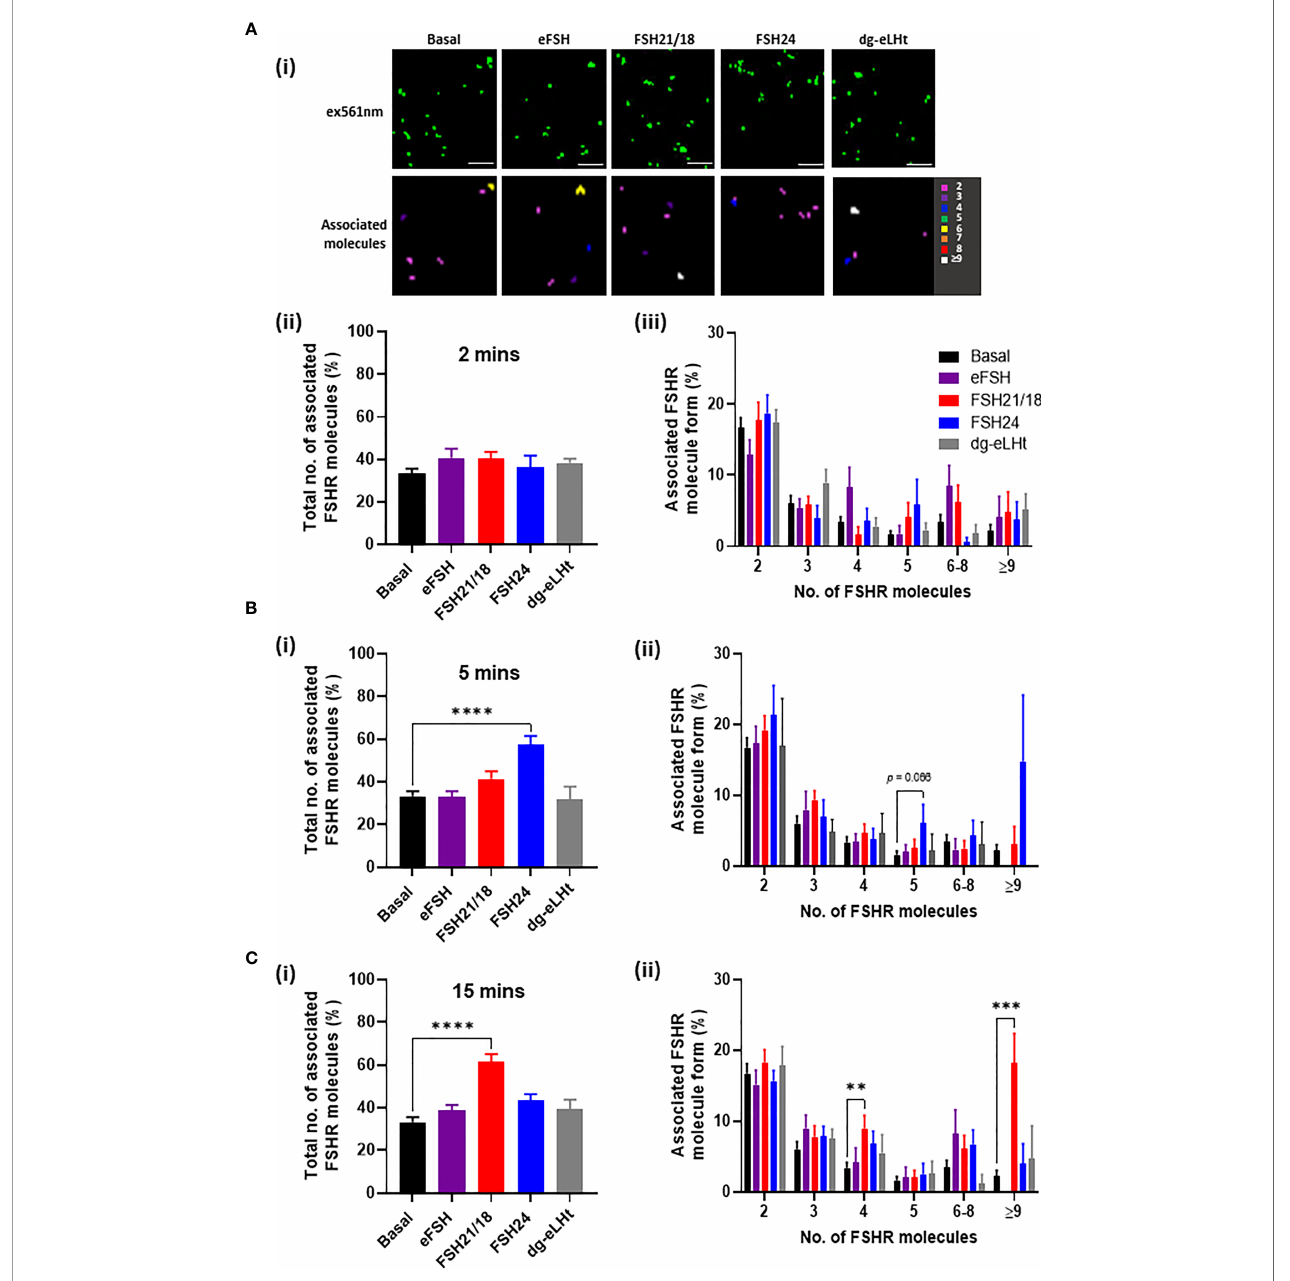
FIGURE 2 | Low FSH ligand concentrations have distinct temporal effects on FSHR association. HEK293 cells expressing HA-tagged FSHR, labelled with CAGE 552- HA antibody and treated with ± 1 ng/ml of eFSH, FSH21/18, FSH24 or dg-eLHt for either (A) 2 minutes, (B) 5 minutes or (C) 15 minutes. Cells were fi xed and imaged via PD-PALM. (Ai) Representative resolved localized FSHR molecules following 2-minute treatment (top panel) and heat map showing associated FSHR molecules). Images are 2µm 2 from a 5µm 2 area. Scale bars , 500nm. (Aii) , (Bi) and (Ci) The percentage of the total number of associated FSHR molecules; data analyzed using ordinary one-way ANOVA. (Aiii), (Bii) and (Cii) The percentage of associated FSHR molecule form; 2 (dimer), 3 (trimer), 4 (tetramer), 5 (pentamer), 6-8, ≥ 9; data analyzed using multiple unpaired t-tests. All data represent mean ± SEM of 3 independent experiments. * p < 0.05; ** p < 0.01; *** p < 0.001; **** p <